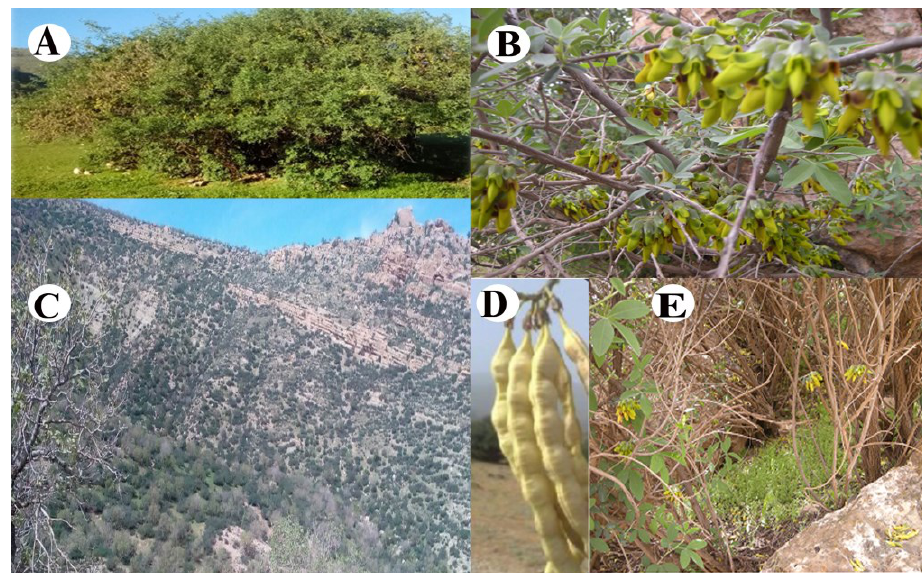
Fig. 1. The bean trefoil ( Anagyris foetida ) and its habitat in the Kaseh-Garan of Gilan-e-Gharb area (Kermanshah province, Iran: A) Bean trefoil shrub in the habitat; B) Flowering branches with compound leaves on them; C) A view of the ecosystem of Zagros forests dominated by oak, with a darker color BeanTrefoil plant in the lower and left corner of the image plants; D) Legume fruits in the bean trefoil; E) Trifolate leaves between the branches of the